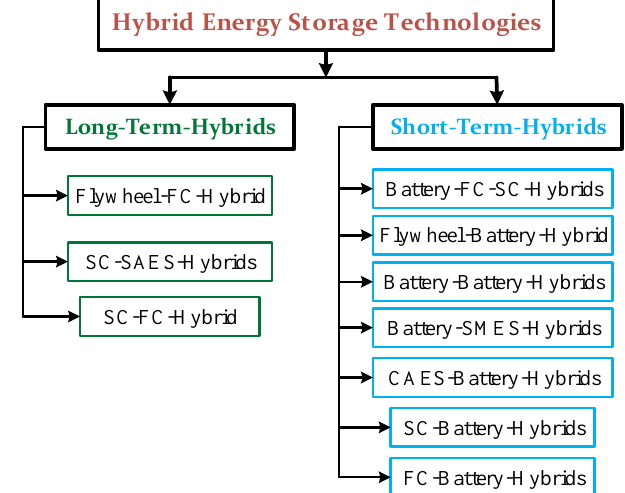
Figure 9. Different methods for storage hybridization with RE systems.